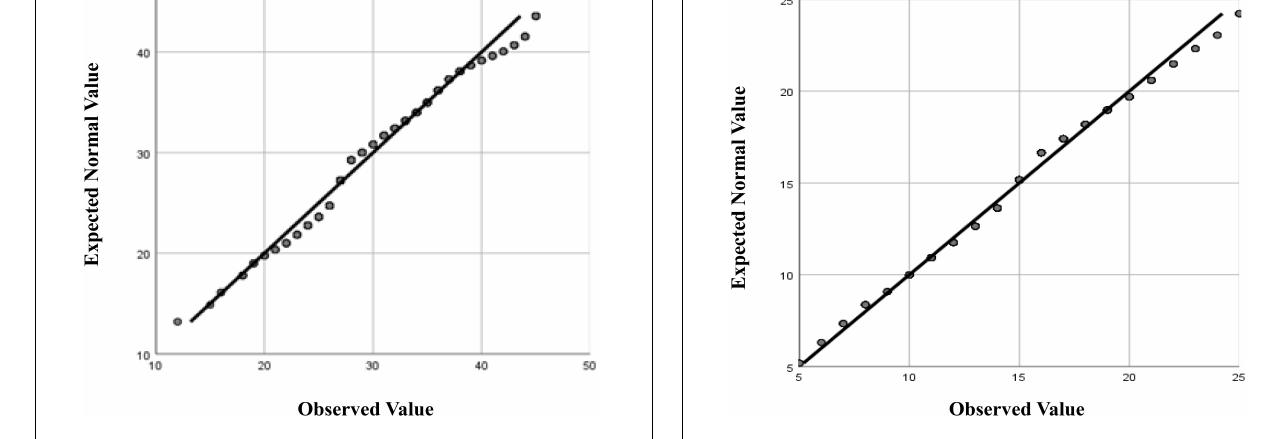
FIGURE 1 | Normal Q-Q Plot of PosFlow. FIGURE 2 | Normal Q-Q Plot of